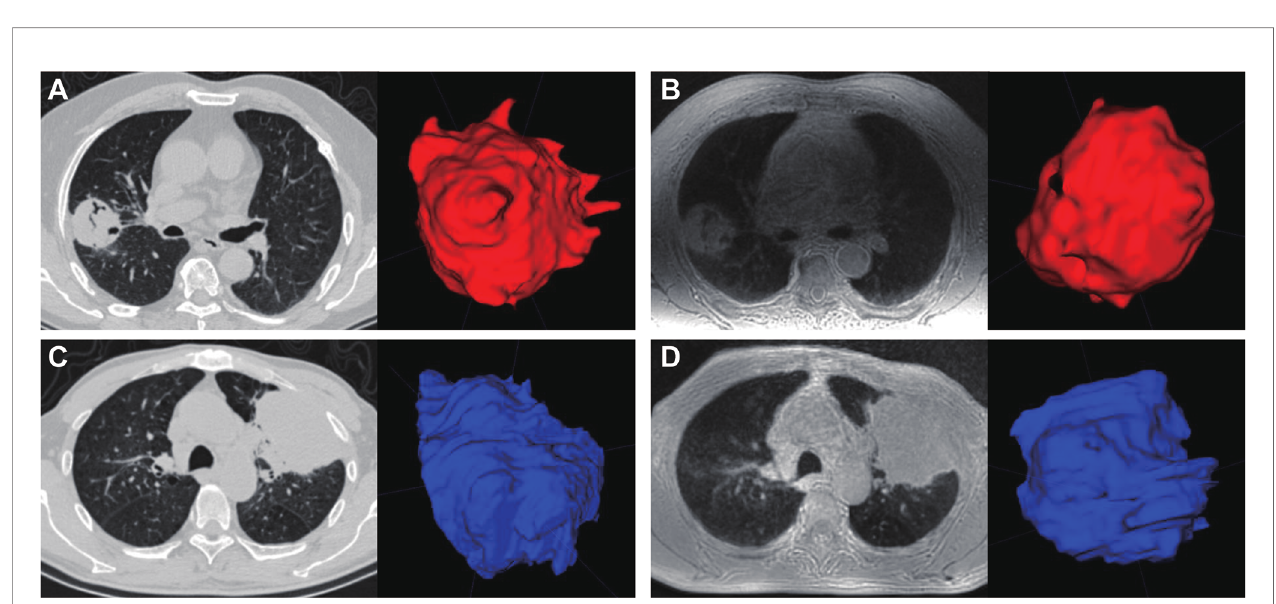
FIGURE 3 | Representative images show the imaging features on CT and ZTE-MRI. Lung adenocarcinoma in the right lower lobe on CT (A) and ZTE-MRI (B) , showing complex shape and air bronchogram sign; lung adenocarcinoma in the right middle lobe on CT (C) and ZTE-MRI (D) , showing non-smooth margin and cavitation; lung adenocarcinoma in the right upper lobe on CT (E) and ZTE-MRI (F) , showing pleural retraction; lung squamous carcinoma in the left lower lobe on CT (G) and ZTE-MRI (H) , showing satellite nodules in the primary tumor lobe and pleural attachment; lung adenocarcinoma carcinoma in the left upper lobe on CT (I) and ZTE-MRI (J) , showing emphysema; lung abscess in the left upper lobe on CT (K) and ZTE-MRI (L) , showing pleural effusion in small amounts.